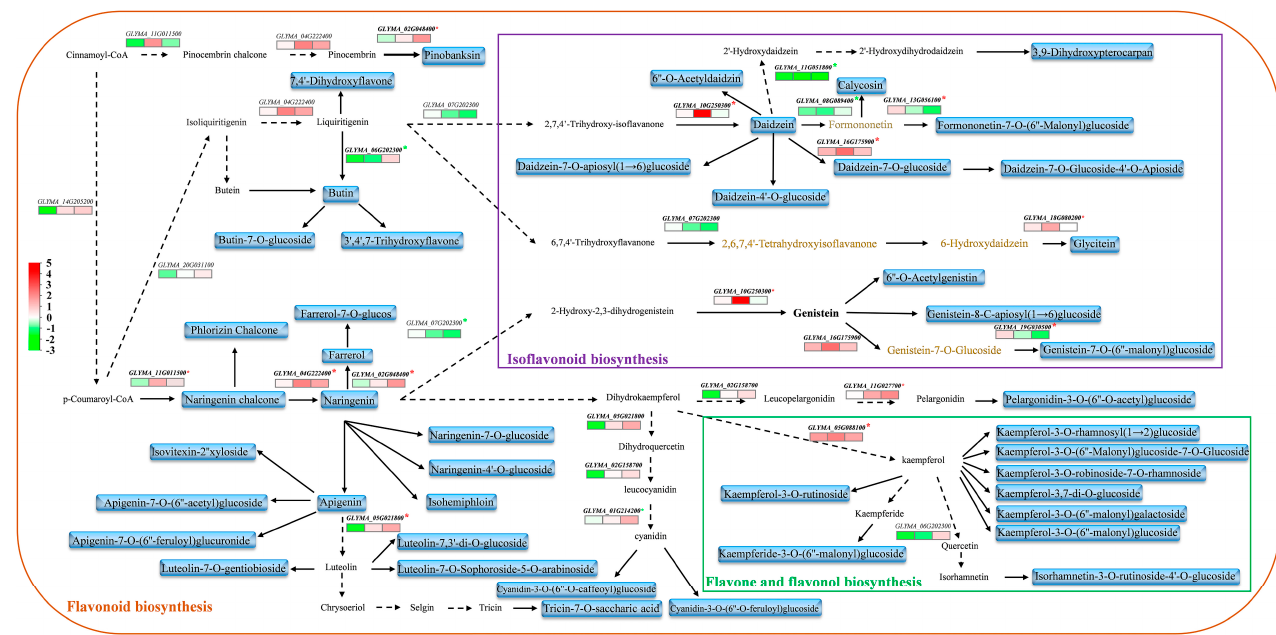
Figure 6. Correlation analysis between differential metabolites and differentially expressed genes of flavonoids and anthocyanins. Black color represents undetected metabolites; Purple represents detected metabolites; and the red asterisk represents a positive correlation and green represents a negative correlation.